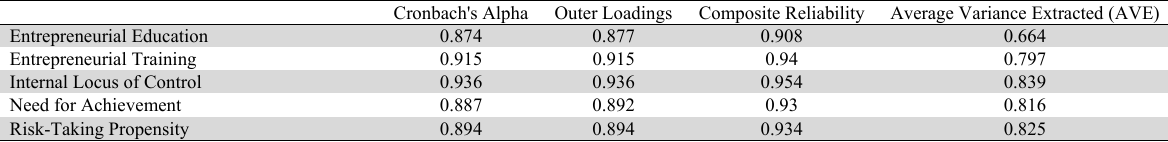
Reliability and Convergent Validity of the